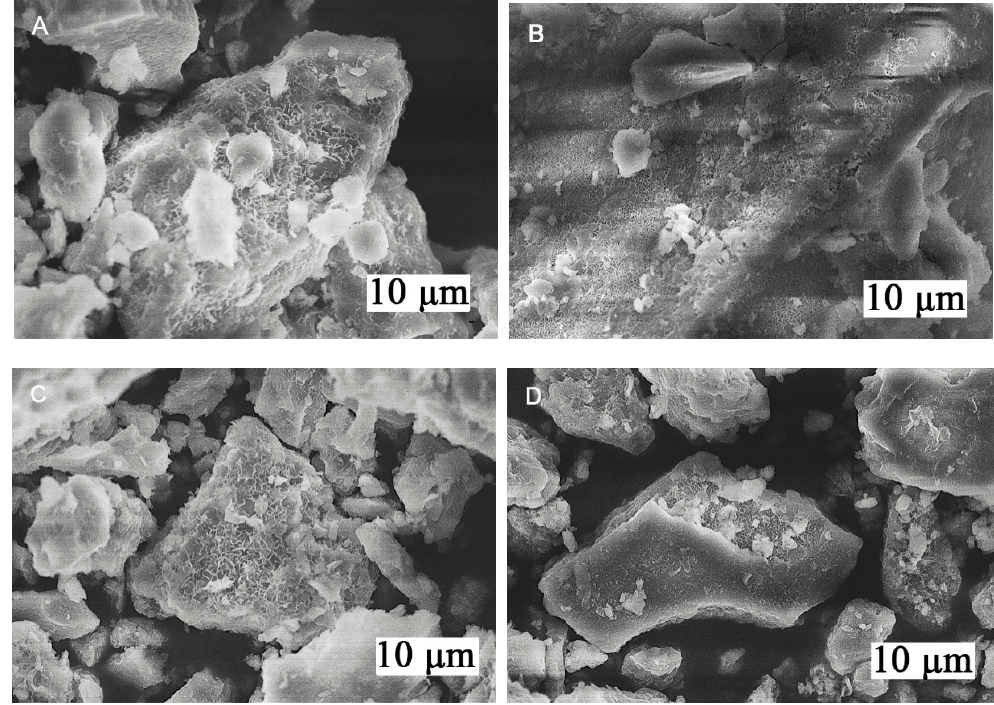
Figure 3. Scanning electron microscope (SEM) micrographs of Cr-substituted Mg 3 Al 1-x Cr x LDHs. The amount of Cr in mol%: ( A ) 1, ( B ) 5, ( C ) 10 and ( D ) 25. The scale bars are the lengths of rectangles.